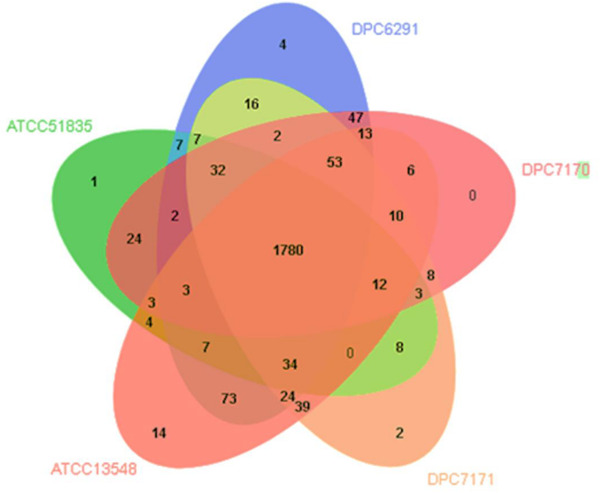
Venn diagram showing shared orthologous protein clusters amongst the five Macrococcus caseolyticus subsp. caseolyticus strains. A total of 2238 clusters were identified, of which 462 were orthologous and 1776 single copy gene cluster identified with the default parameters, 1e–5 e-value cutoff for all protein similarity comparisons and 1.5 inflation value for the generation of orthologous clusters. The numbers in the diagram indicate overlapped conserved gene clusters or un-overlapped specific gene clusters in every single strain.